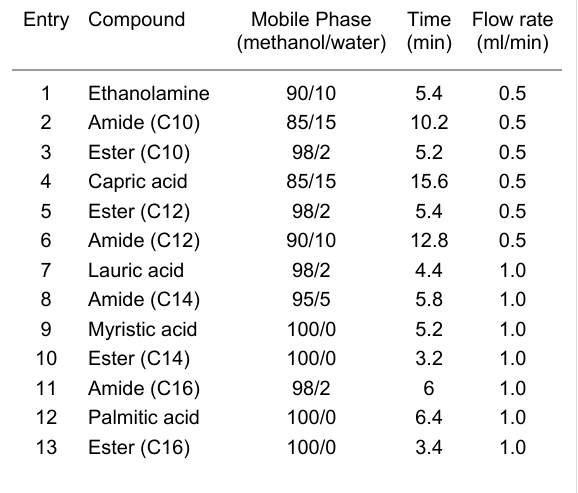
Table 6: Mobile phases, retention time and flow rates for HPLC analyses of the compounds. Entry